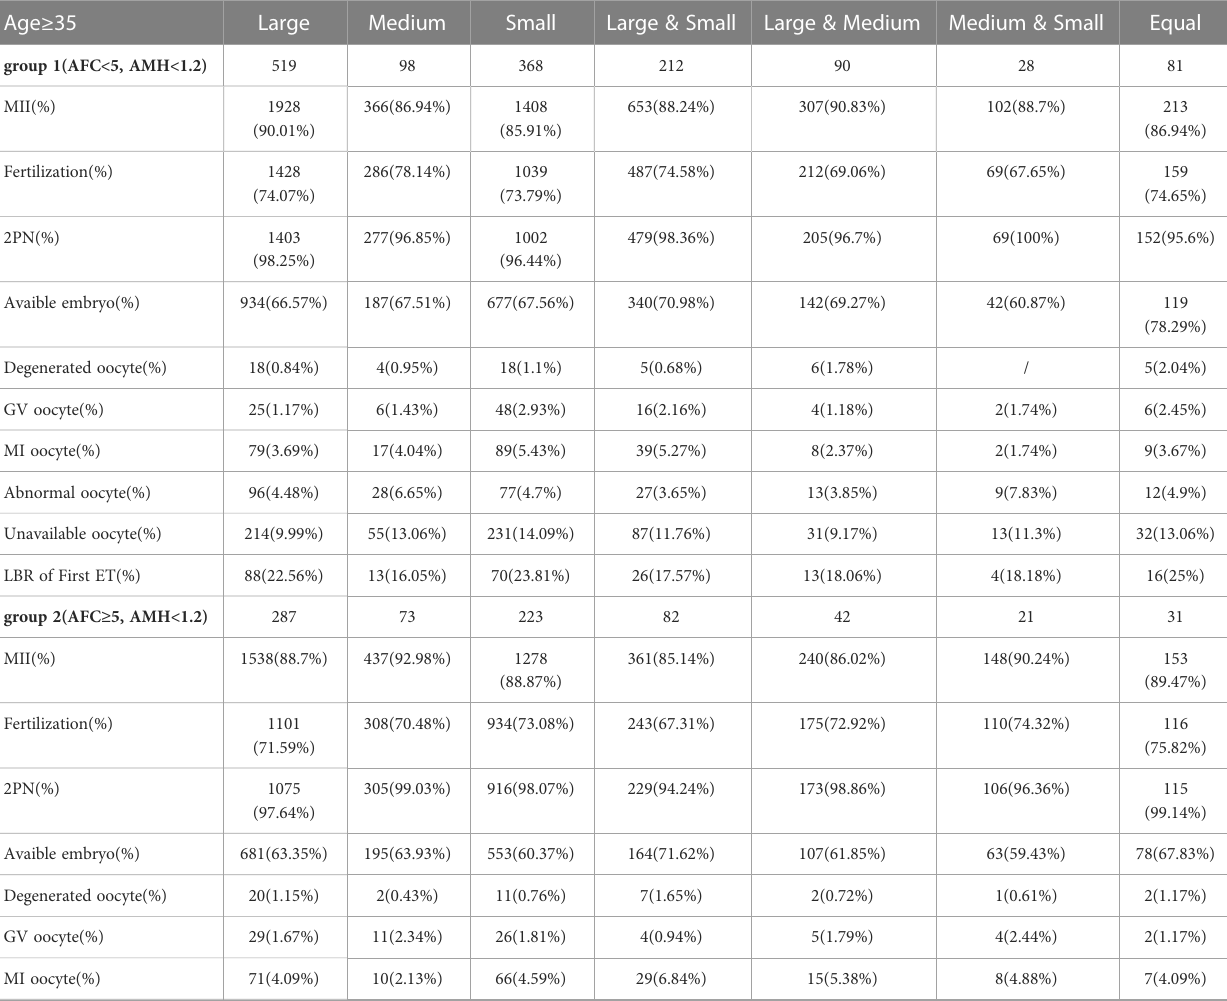
TABLE 3 Strati fi ed analysis of oocyte and embryology quality in groups of follicles size after grouping by AFC and AMH in advanced-age